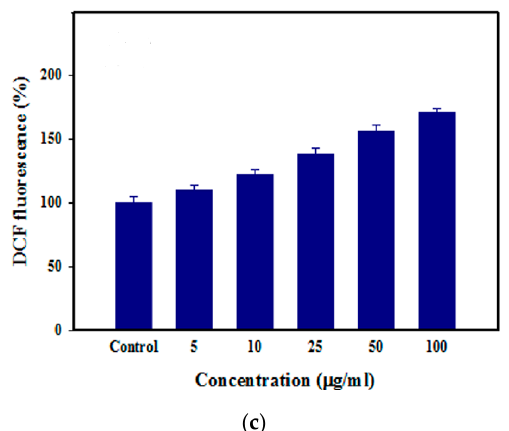
Figure 25. ( a ) SEM images of E. coli with concentrations of 10 6 , 10 7 and 10 8 CFU/mL upon exposure to ZnO nanoparticles of different doses (0.01, 0.1 and 1.0 mg/mL). Reproduced from [278] under a Creative Commons Attribution 4.0 International License. ( b ) SEM images of untreated E. coli cells (left panel) and ZnO NPs treated E. coli cells (right panel). Direct contact of ZnO NPs on bacterial membranes due to electrostatic interactions leads to membrane blebling, membrane damage, and membrane clumping as indicated by white arrows. Reproduced from [275] under a Creative Commons Attribution showing the ROS level in Pseudomonas aeruginosa treated with ZnO NPs (5, 10, 25, 50 and 100 mg/mL)